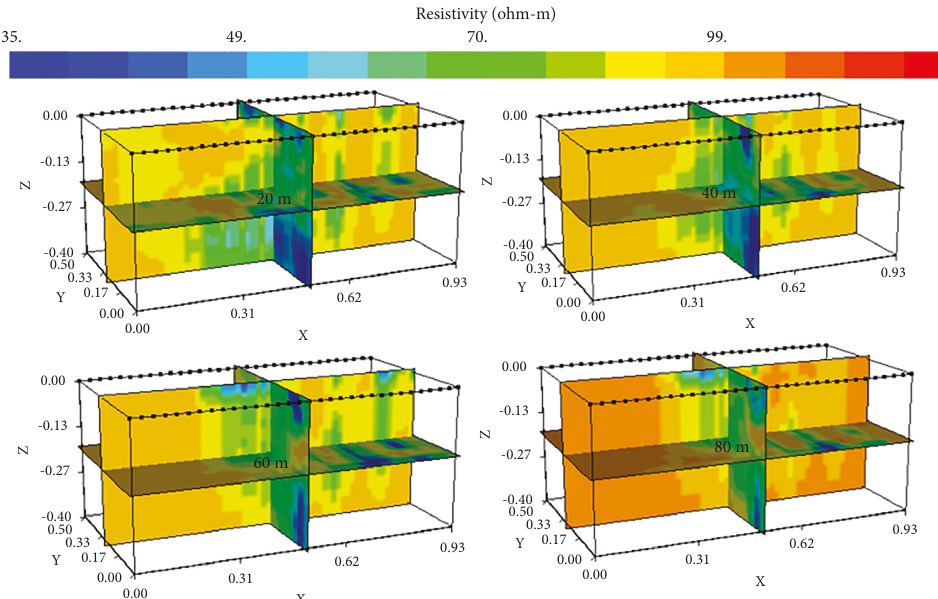
Resistivity (ohm-m)